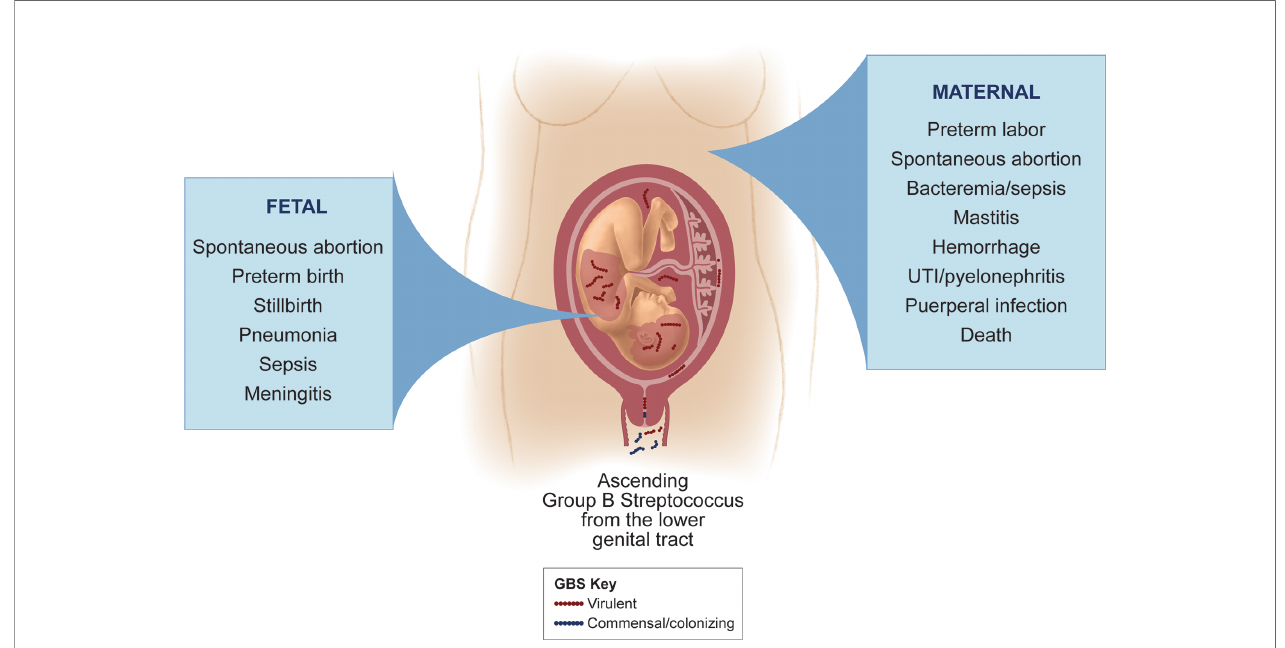
FIGURE 1 | GBS disease manifestations for mothers and fetuses. GBS is considered a commensal colonizer of the maternal vaginal tract, but ascension of GBS into the uterus can lead to adverse perinatal outcomes. GBS can invade the amniotic cavity and fetus to cause a variety of disease manifestations in the fetus (left panel), some of which can occur even with a limited infection of the placental chorioamniotic membranes. Maternal GBS invasive disease is more infrequent and can vary in severity (right panel); more severe outcomes tend to occur in the setting of chorioamniotic membrane rupture and/or with maternal co-morbidities that compromise the immune